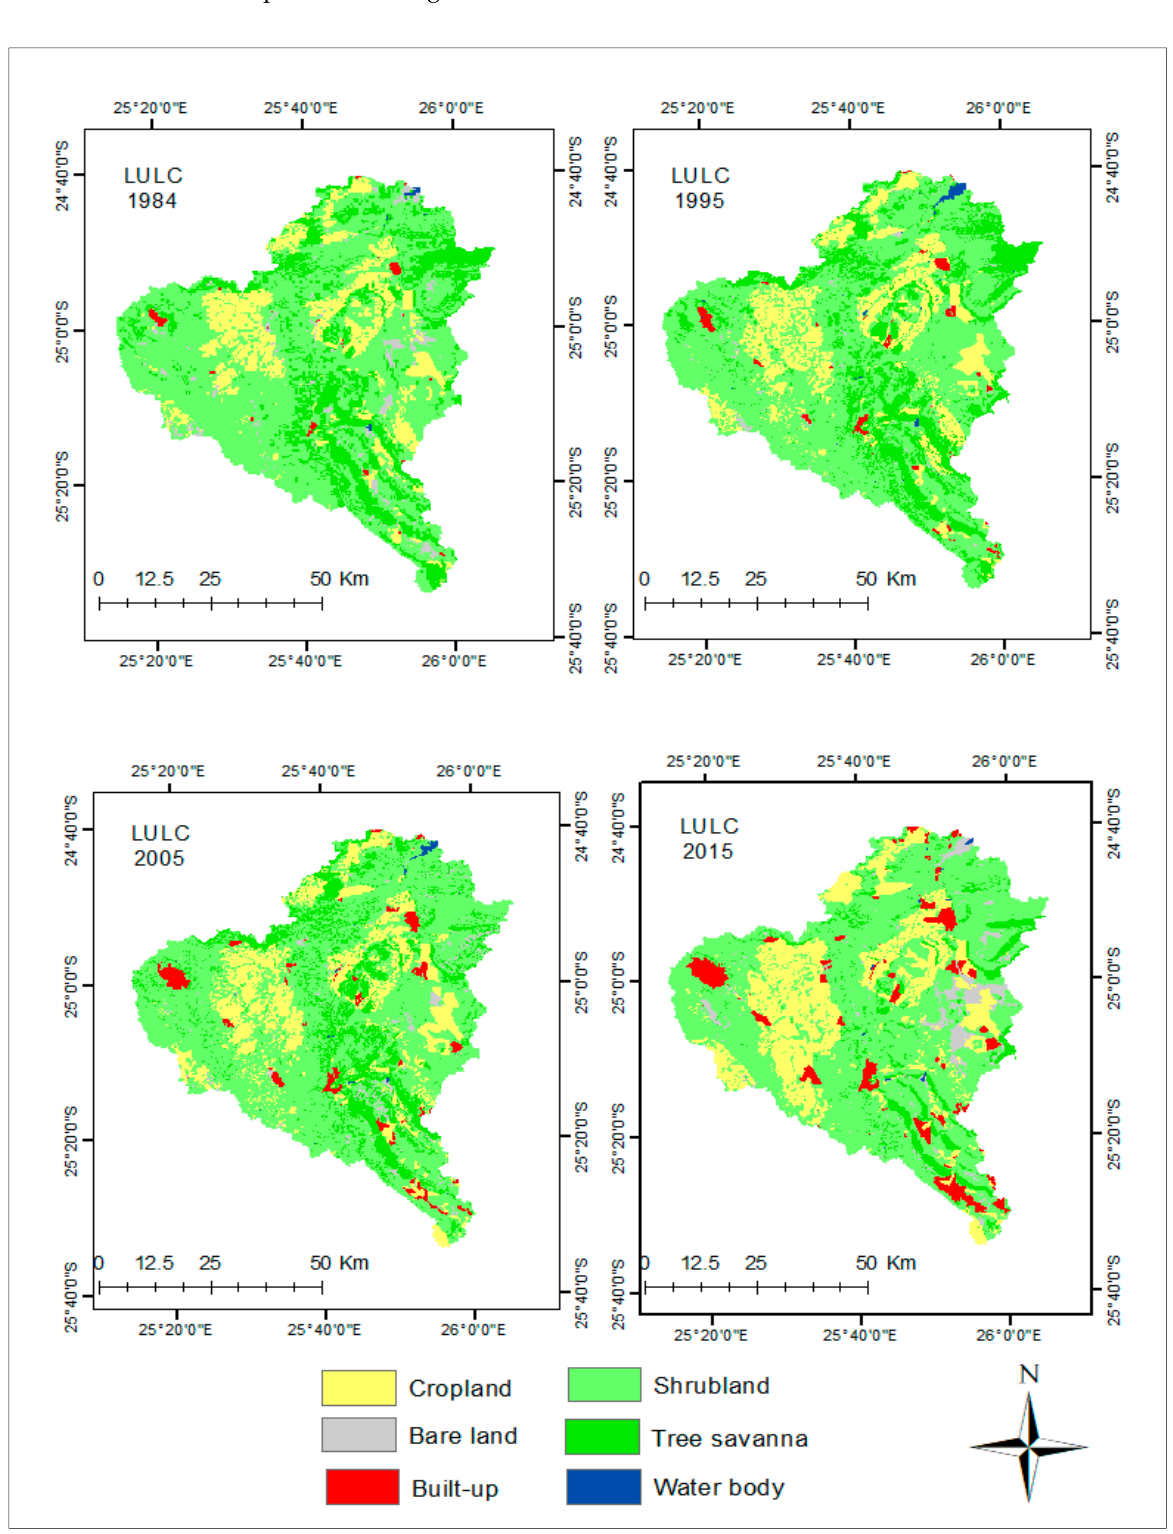
Figure 2. Classified Landsat images for 1984, 1995, 2005 and 2015 for the Gaborone dam catchment